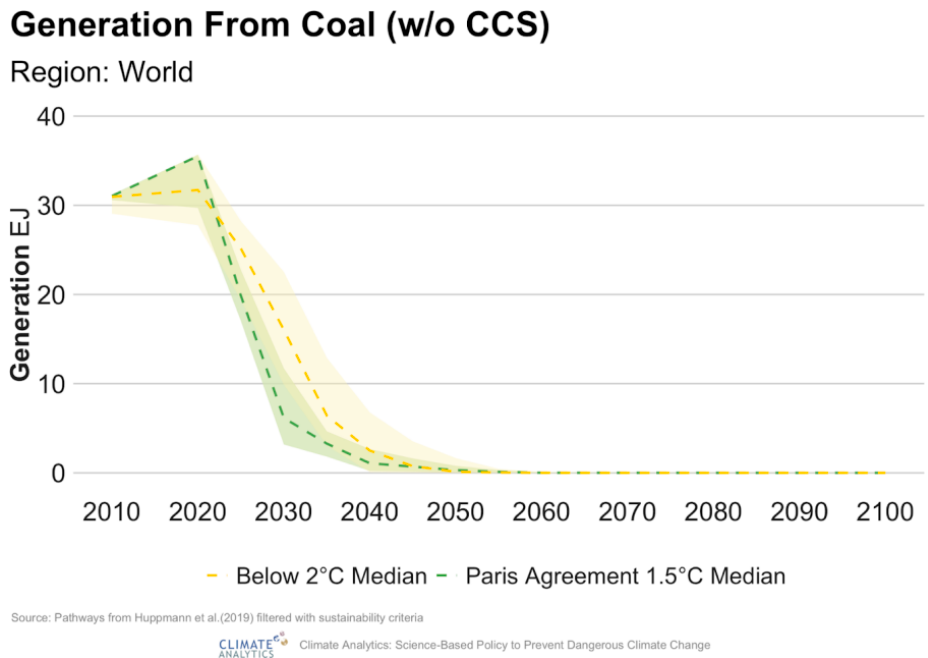
Figure 10. Generation from coal in Paris Agreement compatible and ‘Below 2 °C’ compatible pathways, Reproduced with permission from Climate Analytics [26].